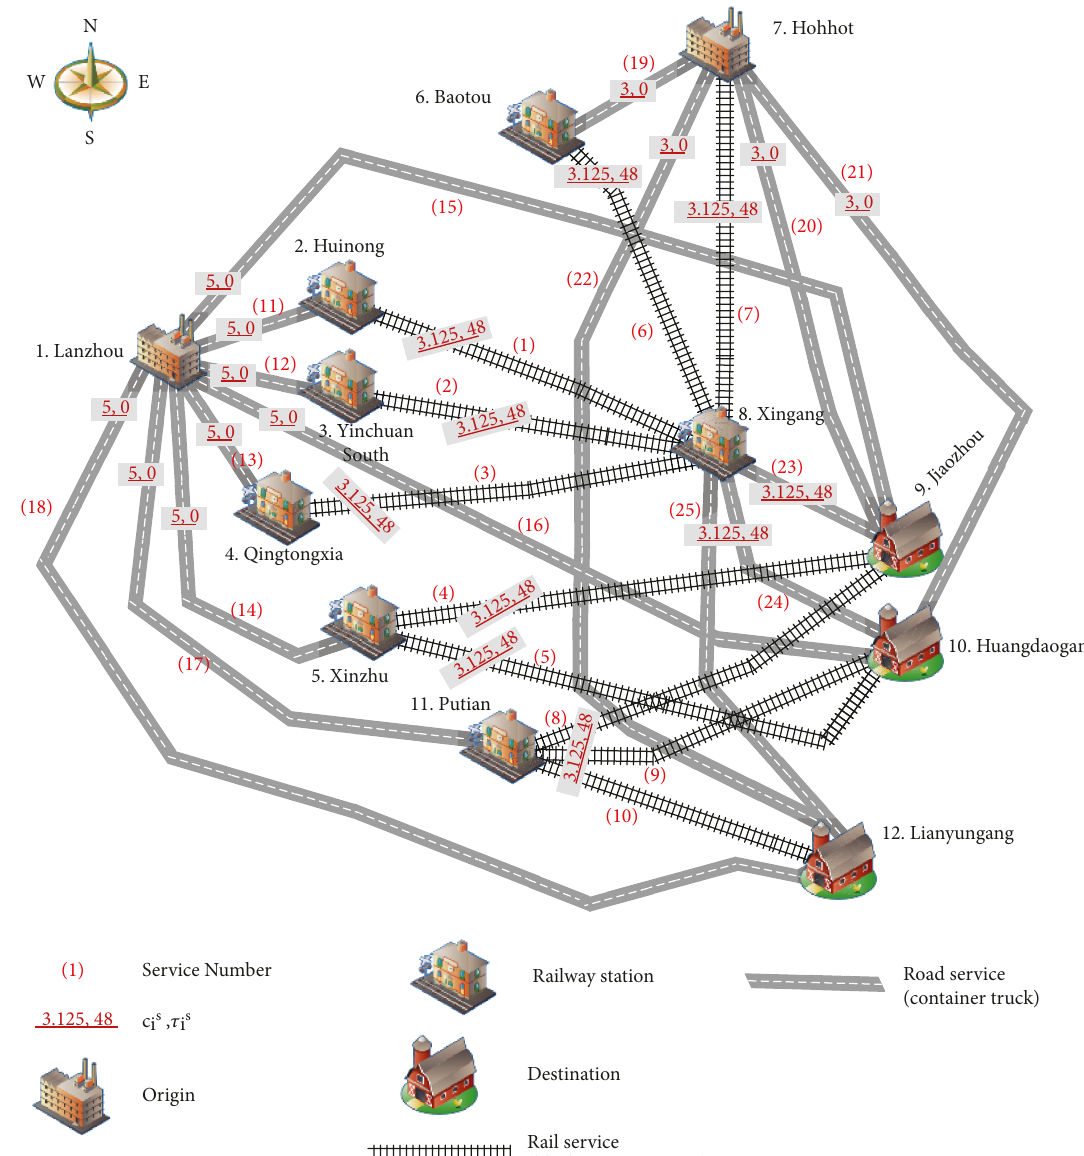
Figure 5: Multimodal service network for the empirical